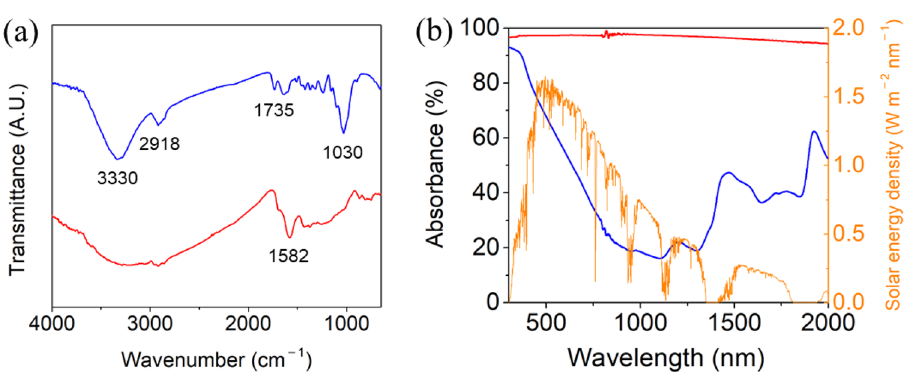
Figure 2. ( a ) FT-IR spectra and ( b ) light adsorption spectra of the DLS (blue) and CLS (red). The light absorbance is obtained by normalizing with AM 1.5G spectrum